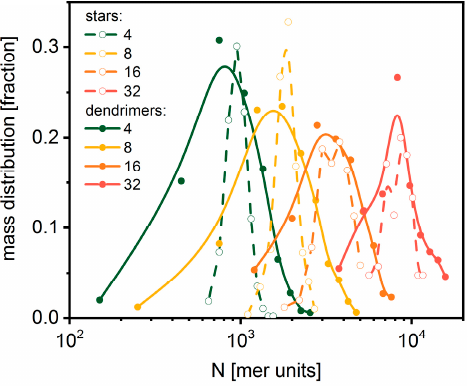
Figure 7. The mass distribution for star-branched polymers (open symbols) and dendrimers (solid symbols). The lines indicate Gaussian fits.